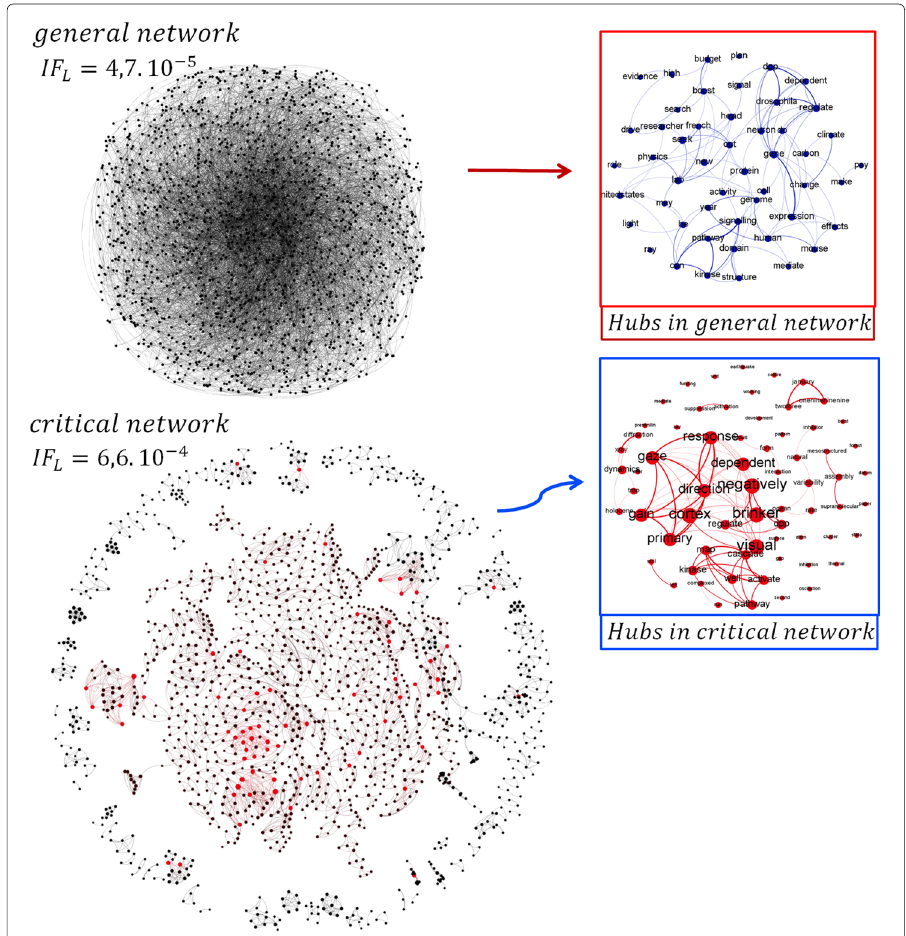
Fig. 10 General network and critical network for Nature in t = 7, with the lowest H (cid:12) e . Hubs ( k hub i ≥ (cid:6) k (cid:7) + 2 σ ) for networks are shown without (top line) and with (bottom line) the IF c = IF L ≈ 10 −